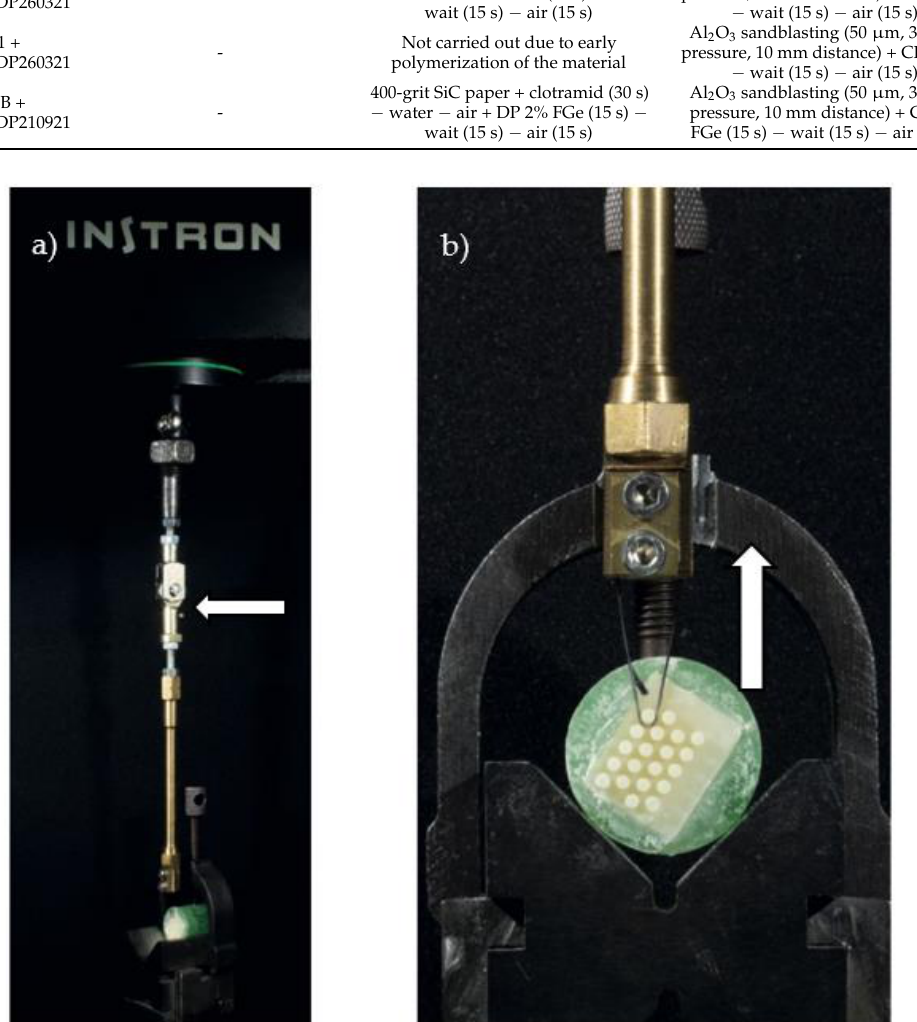
Figure 2. Representation of the mSBS test. ( a ) A pulling arm with a flexible ball-joint connection (white arrow) was fixed to the Instron machine load cell. ( b ) A zirconia ceramic tablet with an array of 20 CBC cylinders adhered to its surface was partially embedded in a green resin cylinder mounted on a V-shaped holder. A 0.30 mm thick steel wire is pulling the first CBC cylinder in an upward direction, generating shear stress on the adhesive interface in parallel to the ceramic plane.